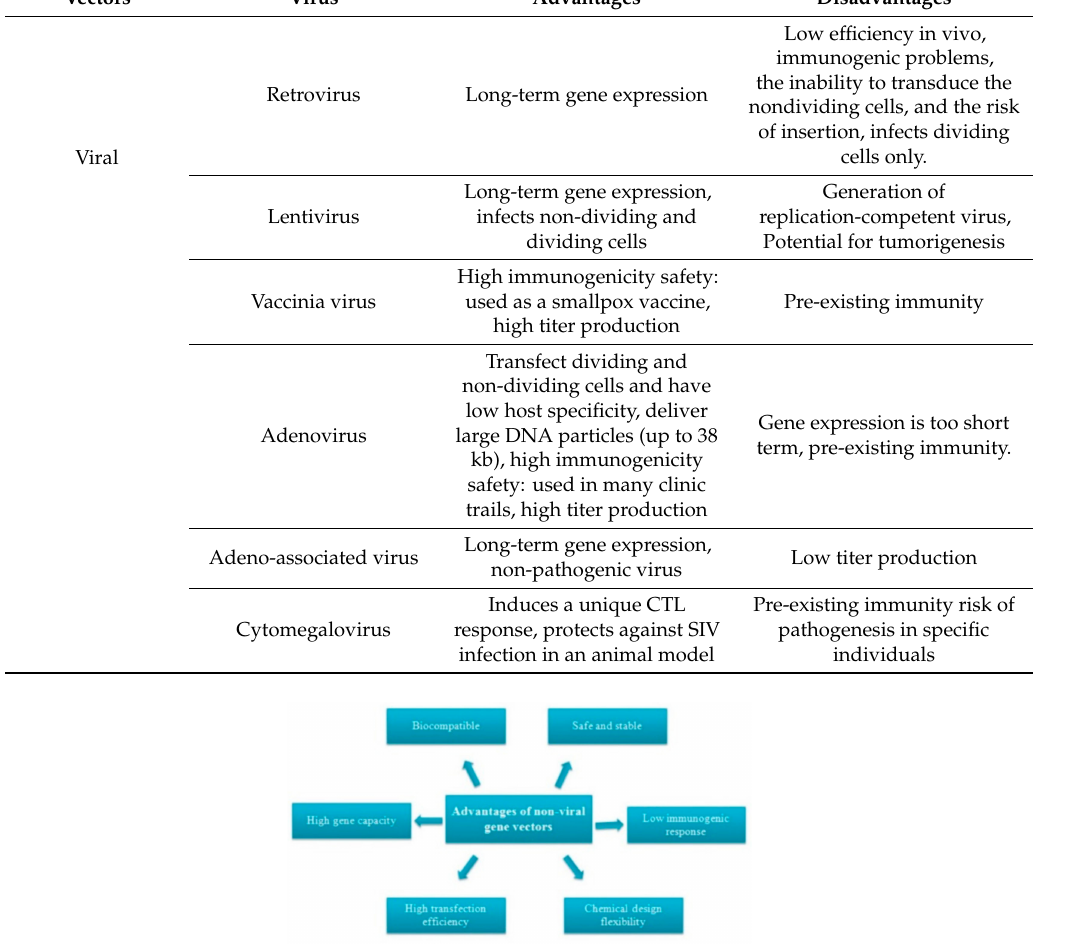
Table 1. Advantages and disadvantages of viral vectors [9].